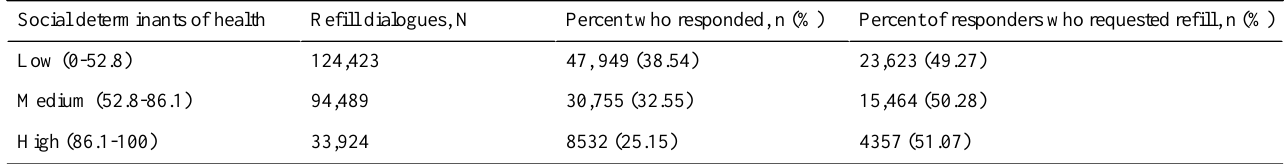
Table 3. Refill request rate for text message group by social determinants of health level.